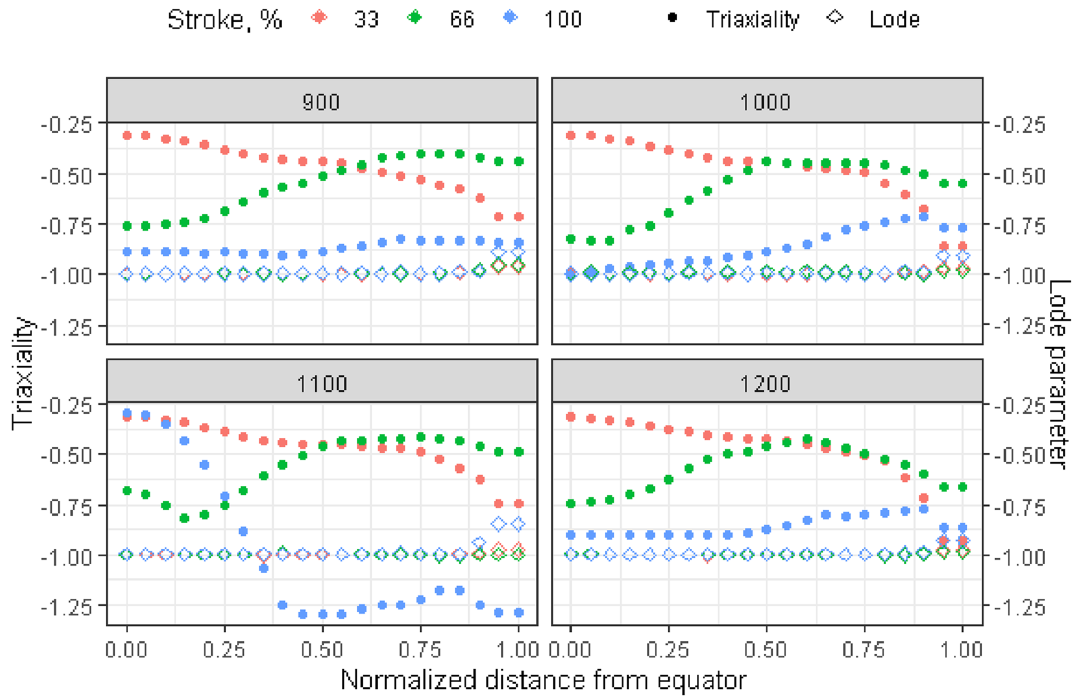
Fig. 13 Lode parameter and triaxiality factor for the axis line in three different compression stages for a nominal strain rate of 30